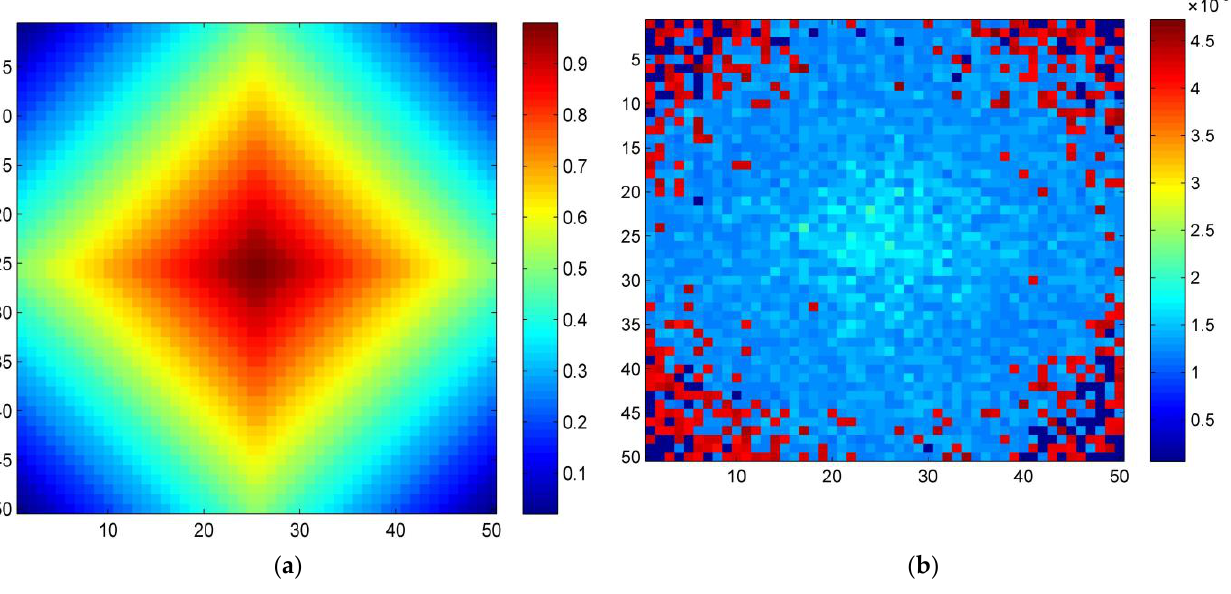
Figure 3. ( a ) Original oil abundance map of the synthetic images; ( b ) estimated oil abundance map of the synthetic image which was generated by multiplying the abundance matrix of ( a ) by 10 − 3 , and derived by unmixing with ENPSM.